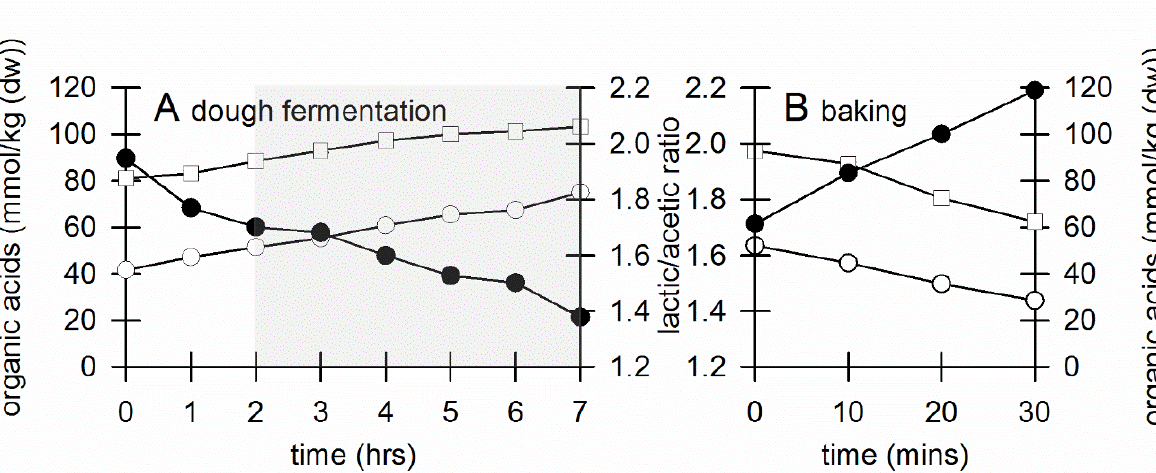
Figure 5. Lactic acid and acetic acid content of sourdough with an inclusion of FBSG at 10% during dough fermentation ( A ) and baking of sourdough ( B ). lactic acid, acetic acid, lactic acid to acetic acid ratio. The greyed-out area in ( A ) represent an extended proofing period (>2 hrs) of the dough beyond the samples represented in ( B ), which were baked following a final proofing of 2 hrs. The data shown are the average and standard deviation of triplicate samples. The standard deviations are indicated with whiskers that are barely visible.